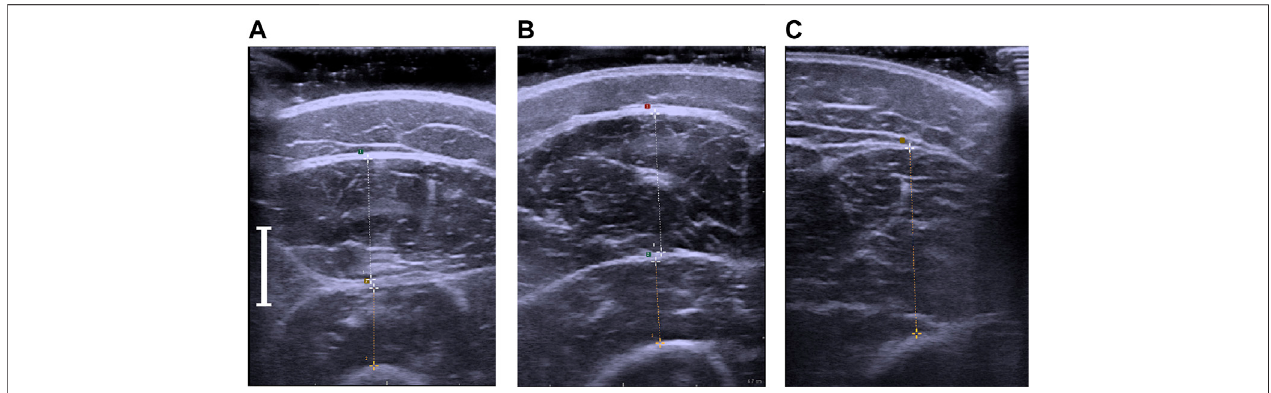
FIGURE 1 | (A) . Ultrasonographic measurement of the m. rectus femoris and m. vastus intermedius. (B) Ultrasonographic measurement of the m. vastus lateralis and m. vastus intermedius. (C) Ultrasonographic measurement of the m. vastus medialis. The white indicator shows the length of 1 cm.